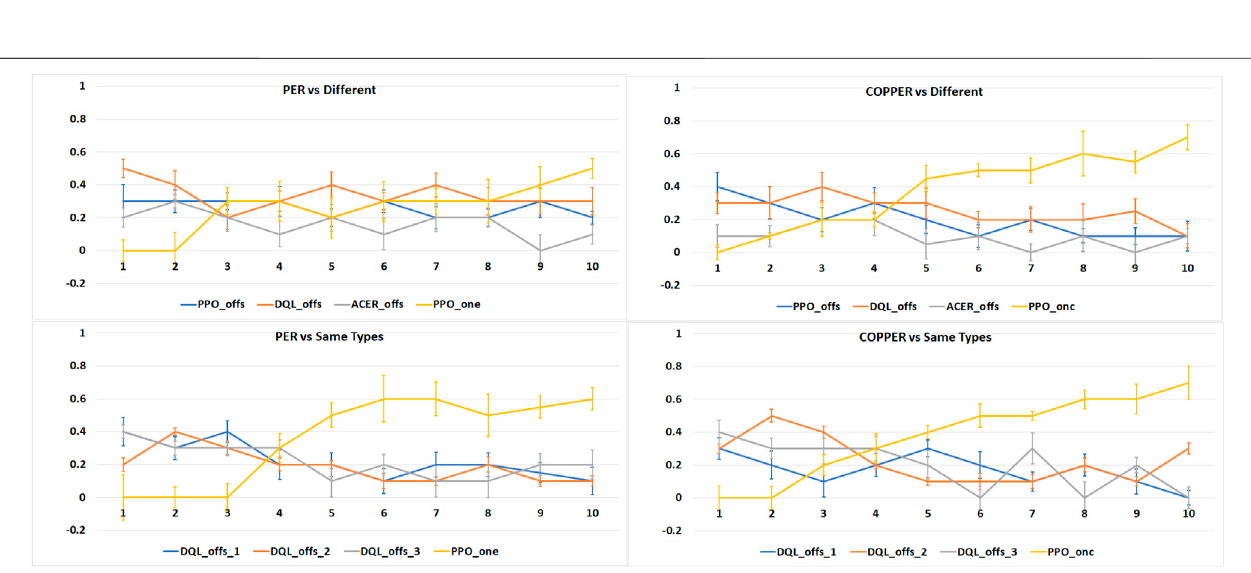
FIGURE7| Averagenumberofvictories(Y-axis),in1,000runsof10tournaments(X-axis),perexperimenttype:onlinelearningagentsvs.thesametypesofagents and online learning agents vs. different types of agents.